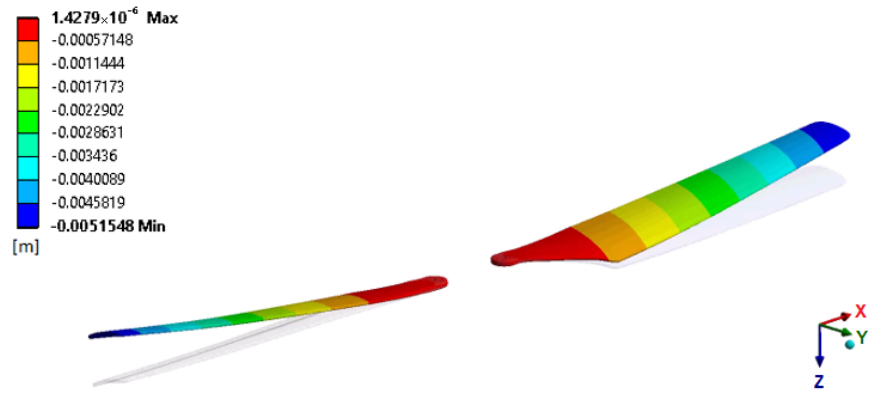
Figure 21. Mechanical simulation result—vdisplacement in Z direction at the 0.5s instant.